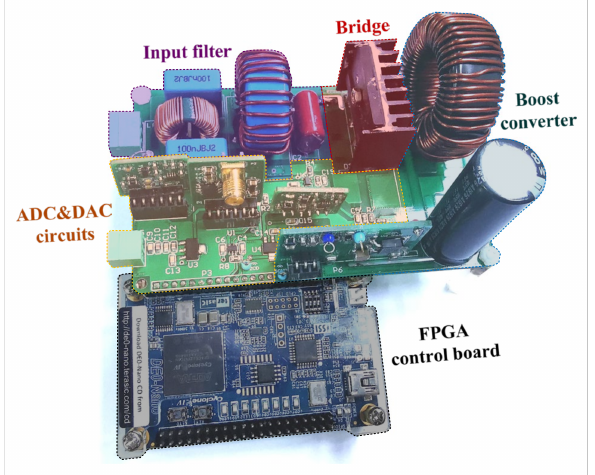
Figure 11. Experimental